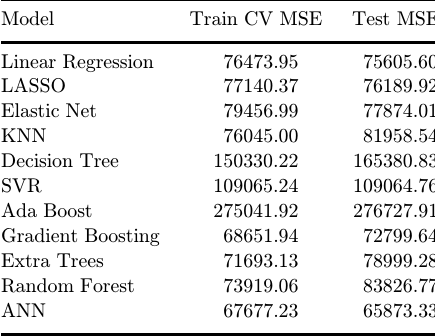
Table 5. Regression results of all machine learning models including neural networks using satellite image- driven